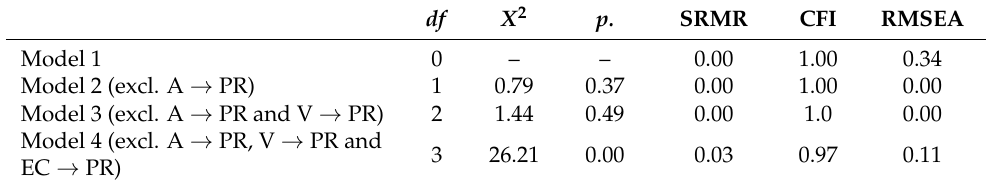
Table 2. Fit indicators of structural models.